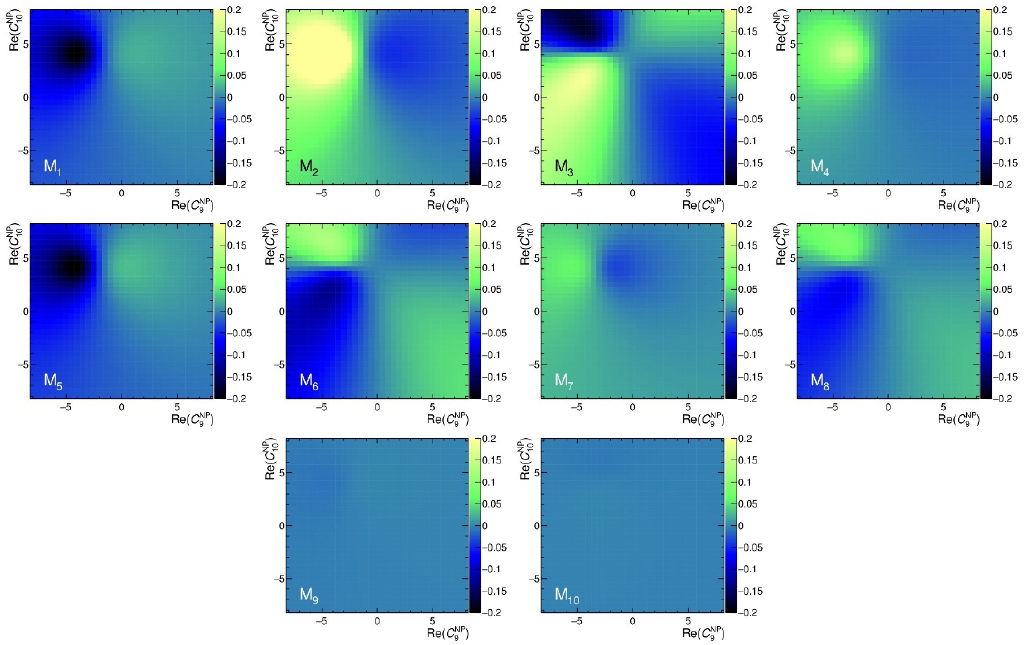
+ (cid:22) (cid:0) decay from their SM central 1 { M 10 of the (cid:3) b ! (cid:3) (cid:22)